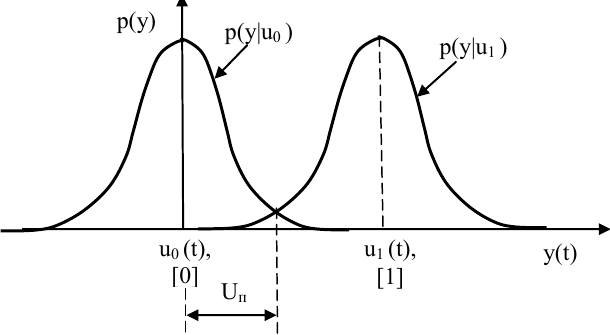
Fig. 4. The form of conditional densities functions of y(t) signal distribution of transfer 0 and 1 digital